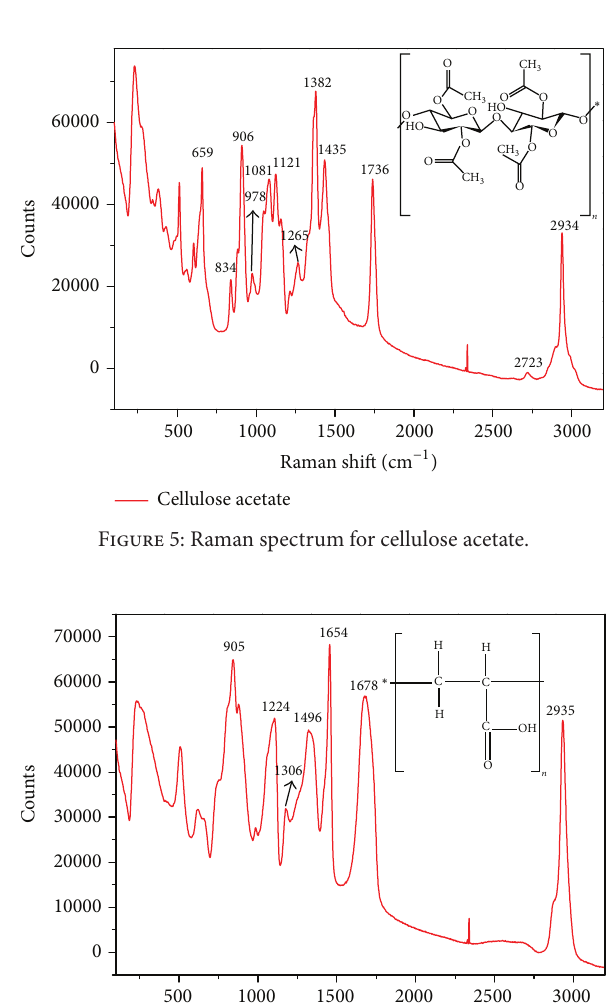
Figure 4: Raman spectra of the raw CNTs and oxidized CNTs.